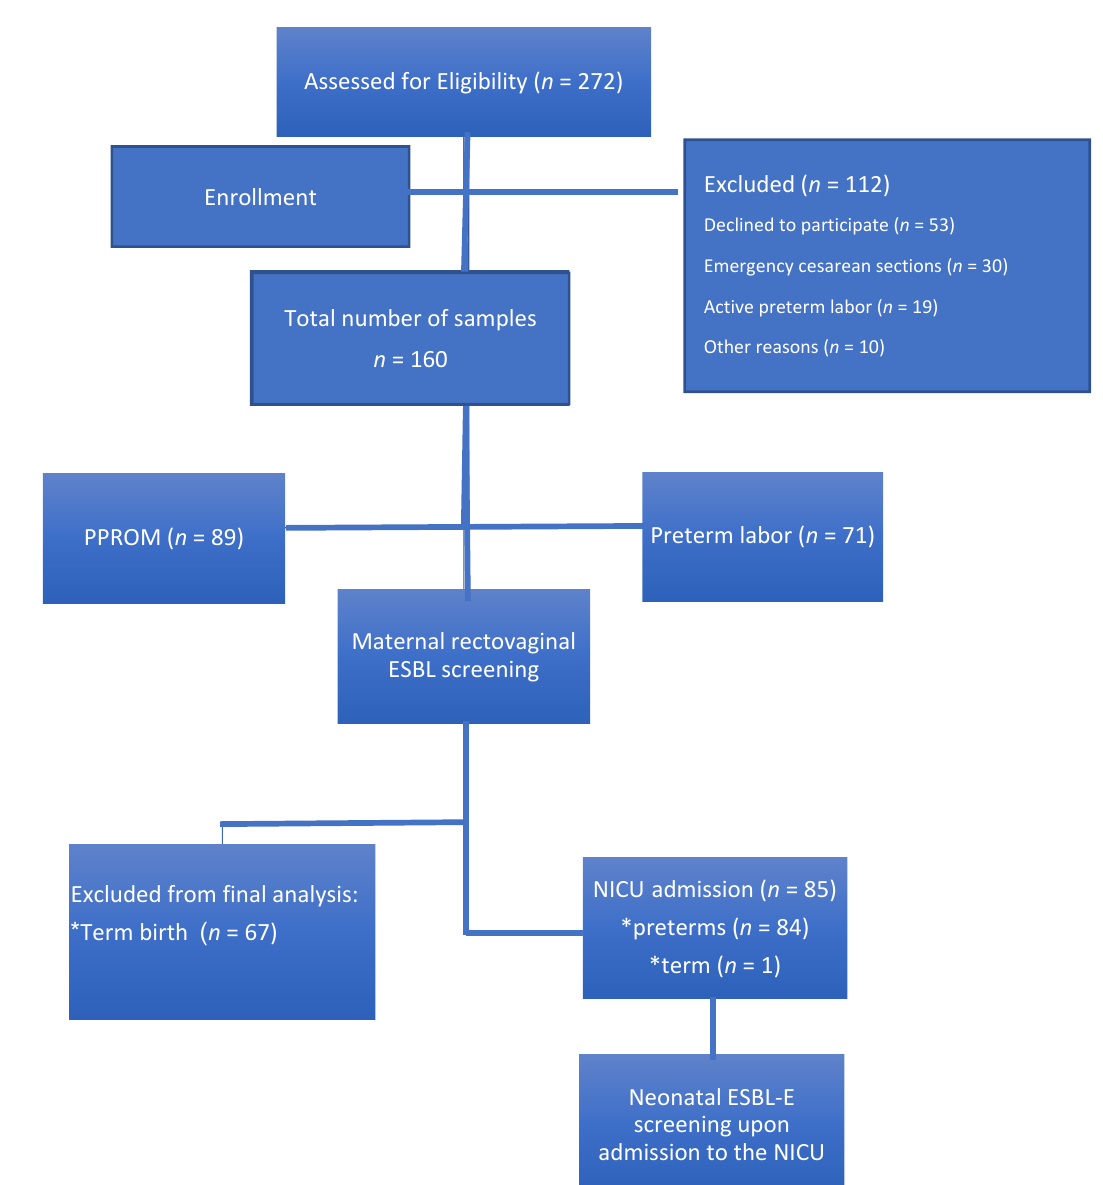
Figure 1. Study population. ESBL-E: extended-spectrum beta-lactamase-producing Enterobacteriaceae ; NICU: neonatal intensive care unit; PPROM: preterm premature rupture of